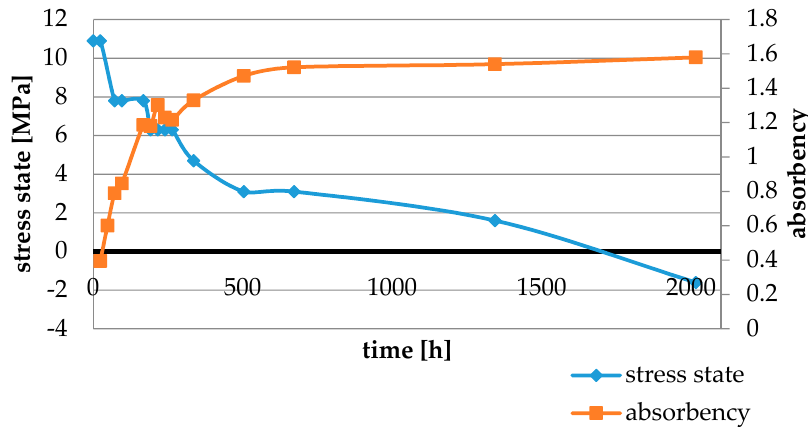
Figure 2. The influence of water sorption (2016 h water ageing) on the absorbency and contraction stress generated during the photopolymerization of Cement It.